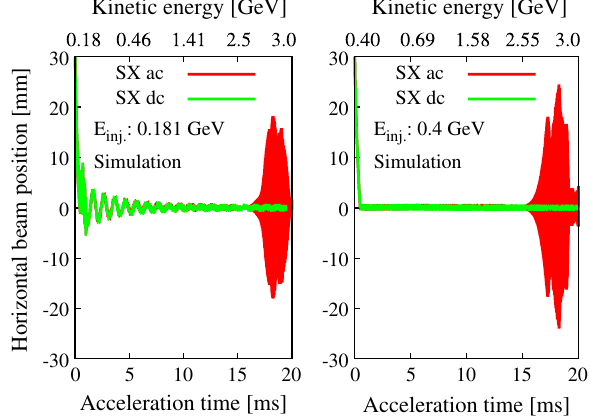
FIG. 11. Beam centroid motion and instability growth due to the transverse impedance of extraction kicker magnets, as obtained in the simulation at a beam power of 0.5 MW. The values of E in the left and the right figures are 0.181 and inj 0.4 GeV, respectively. Beam instability occurs only when ξ is fully corrected for the entire acceleration period, but no beam instability occurs if ξ is fully corrected only at the injection energy.